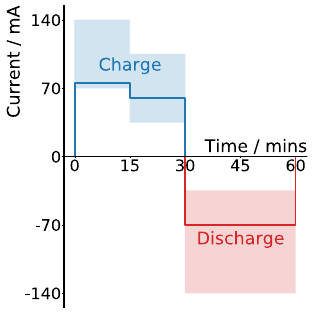
Fig.2|Proposedcharge-dischargeprotocol. Wegeneratebatterycyclingdataby subjecting cells to a sequence of random chargeand dischargecurrents. We apply two stages of constant current (CC) charging for up to 15 min each, with currents drawnfromtheranges70 – 140mA(2 – 4C)and35 – 105mA(1 – 3C),respectively(the blue shaded region). If the safety threshold voltage of 4.3V is reached before the time limit, then charging is stopped. During discharging, a single constant dis- charge current, randomly selected in the range 35 – 140mA (1 – 4C), is applied (the red shaded region), until the voltage drops to 3.0 V.